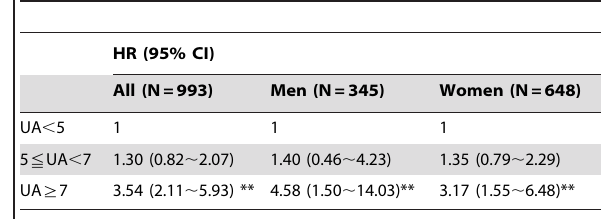
Table 5. Hazard Ratios for development of microalbuminuria in different uric acid tertiles by Cox regression analysis (the lowest tertile as